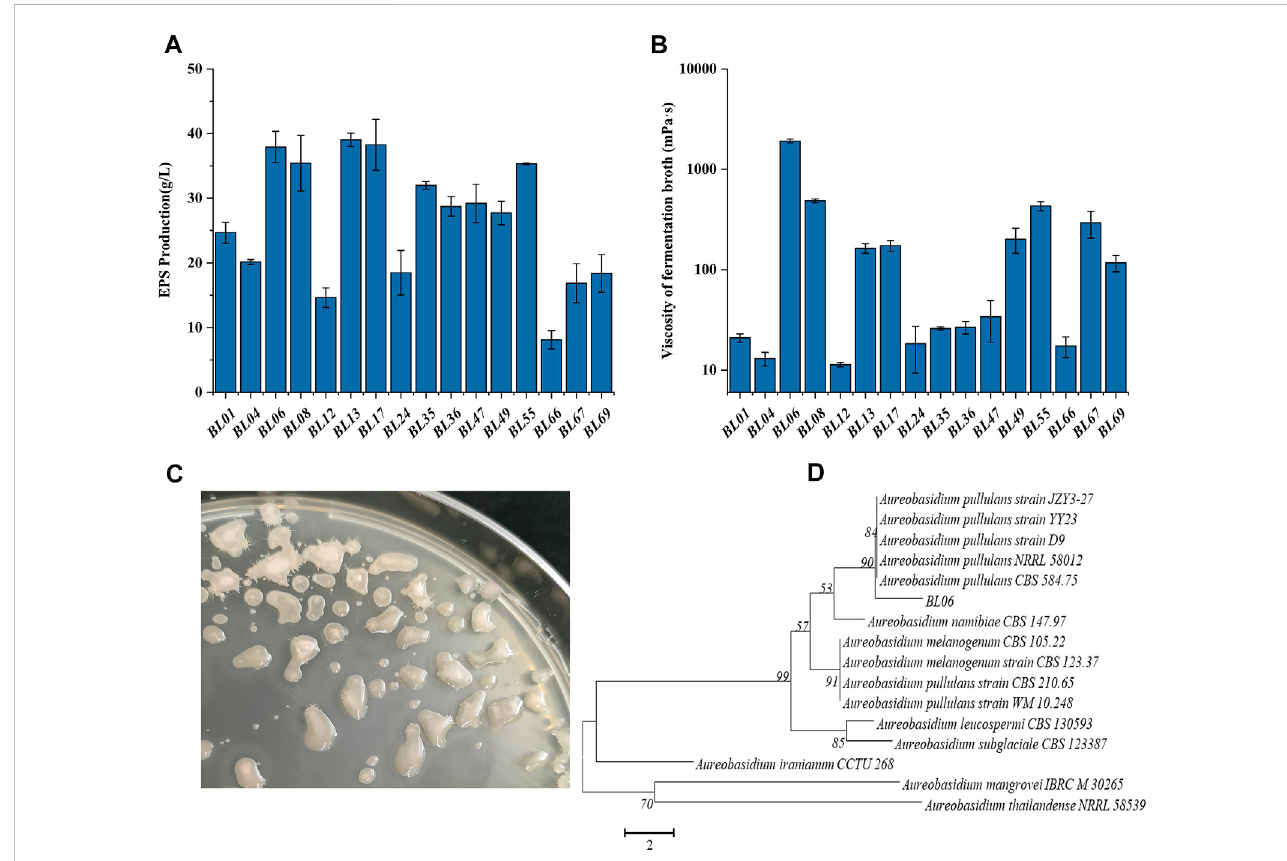
FIGURE 1 Screening and identi fi cation of wild strains for high production of EPS. (A) EPS production of the selected wild strains; (B) Viscosity of the fermentation brothoftheselectedwildstrains; (C) ColonialmorphologyofstrainBL06onaPDAplatefor120 hofcultivation; (D) PhylogenetictreeofstrainBL06andother yeast-like fungal species relatives based on a neighbor-joining analysis of ITS sequences. All values are expressed as the means ± SDs ( n =